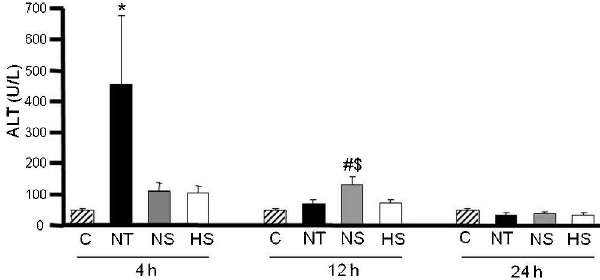
Figure 5 - Serum ALT levels in rats in the control (C), NS, HS, and NT groups. Data are means ¡ SEM, n = 6 in each group. * P , 0.05